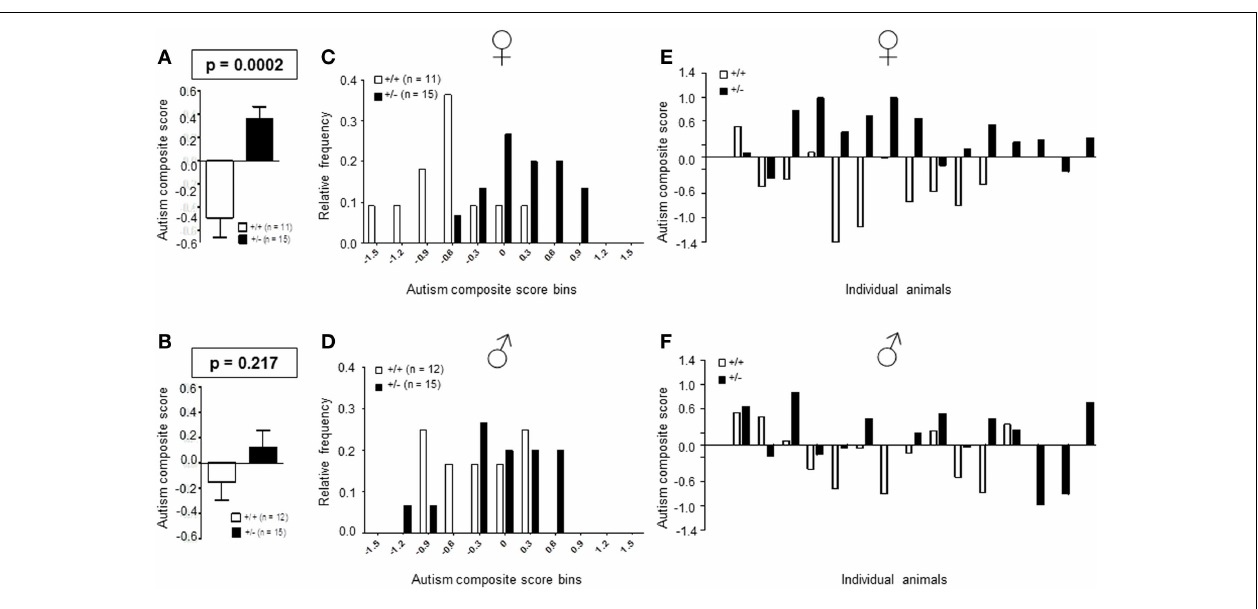
difference in female but not male mice; mean ± SEM presented. (C,D) Frequency distribution of autism composite score bins dependent on genotype; (E,F) Composite score presentation of all individual animals reveals a clear discrimination between genotypes in female but not male mice.